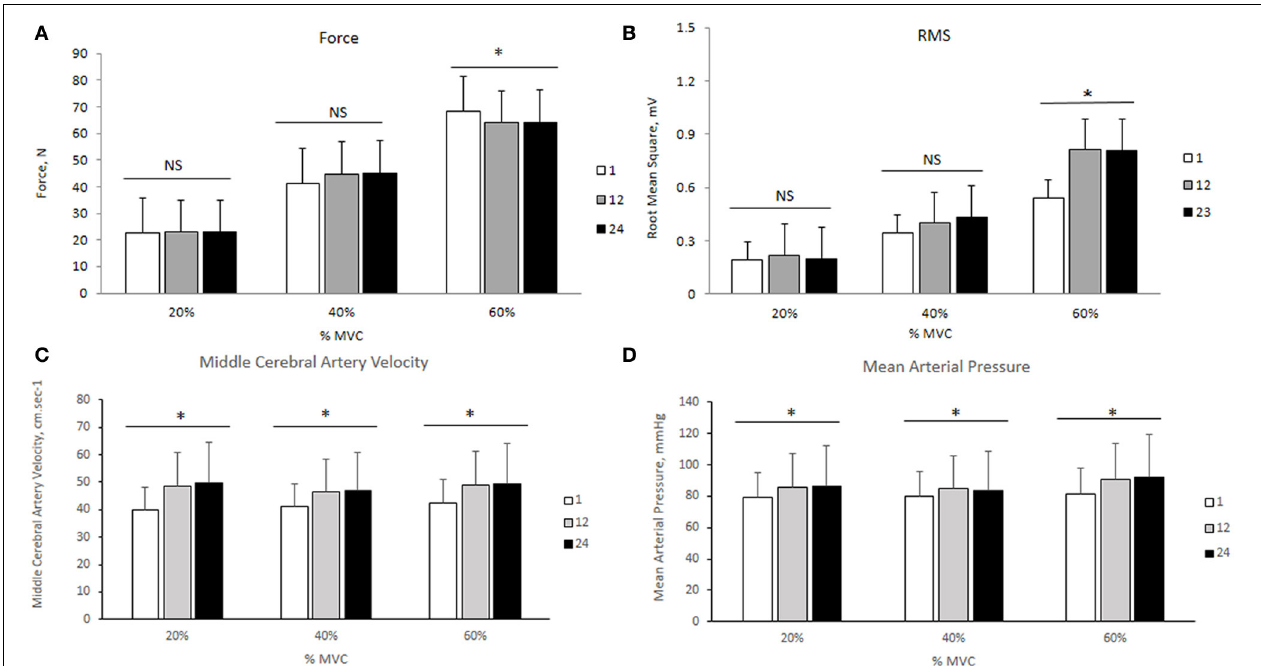
FIGURE 3 | Force output, root mean square, middle cerebral artery velocity, and mean arterial pressure during 24 intermittent isometric contractions of the biceps brachii at three different intensities. ∗ Indicates P < 0 .